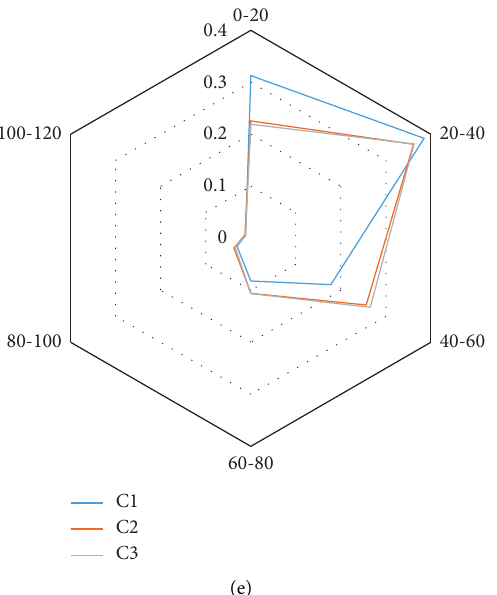
Figure 9: Three mobility patterns recognized by the proposed method when δ � 14 and ε � 10. (a) POI categories around the origin station. (b) POI categories around the destination station. (c) The start time of the day. (d) The day of week. (e) Travel